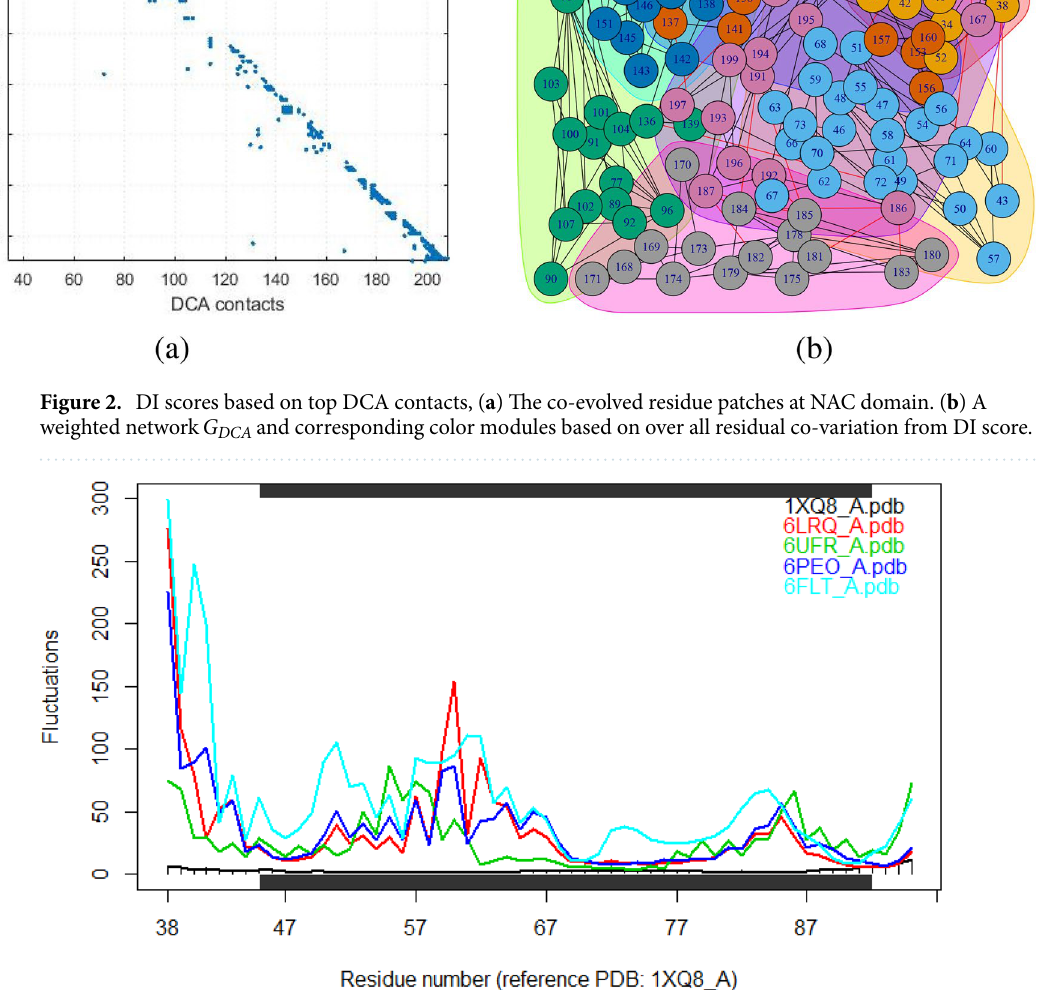
Figure 3. Square fluctuation map on PDB structures of alpha synuclein where each color represents one monomeric